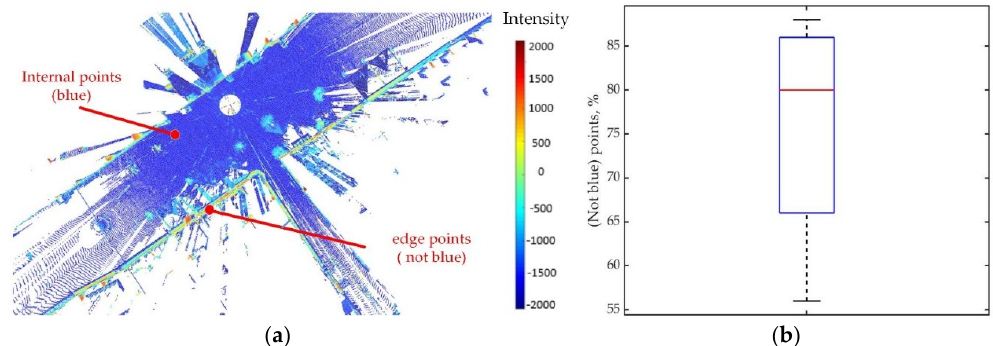
Figure 2. ( a ) Depending on the distribution of intensity value in point cloud, it can be found that the high-intensity points (not blue) are usually on the edge of point cloud with low-intensity points (blue) inside. Therefore, the point cloud composed of high intensity points can represent the shape of the point cloud. ( b ) Based on 100 times experiments to intensity point selection, it can be seen that most of points (not blue) can be extracted for filtered point cloud by Equation (8) and Equation (9). As shown in Figure 2a, the intensity value of most of points on the edge of the point cloud is higher than −1000. This is caused by the most points on edge are green points with the intensity of between −1000 and 0. Therefore, the criterion of the salient point x